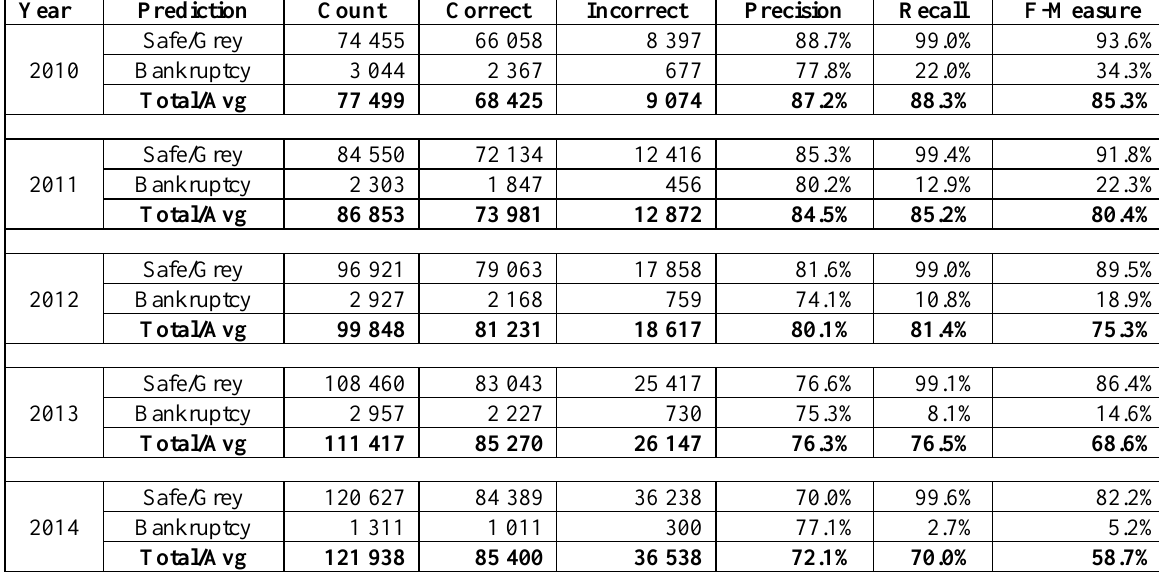
Table 6. Evaluation of Bankruptcy prediction based on